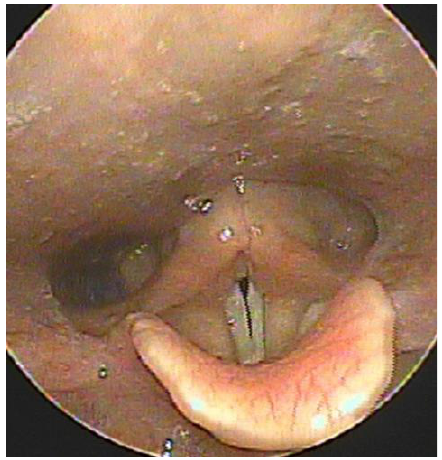
Figure 4. Laryngoscopic view of improved retropharyngeal swelling on the second day of admission.